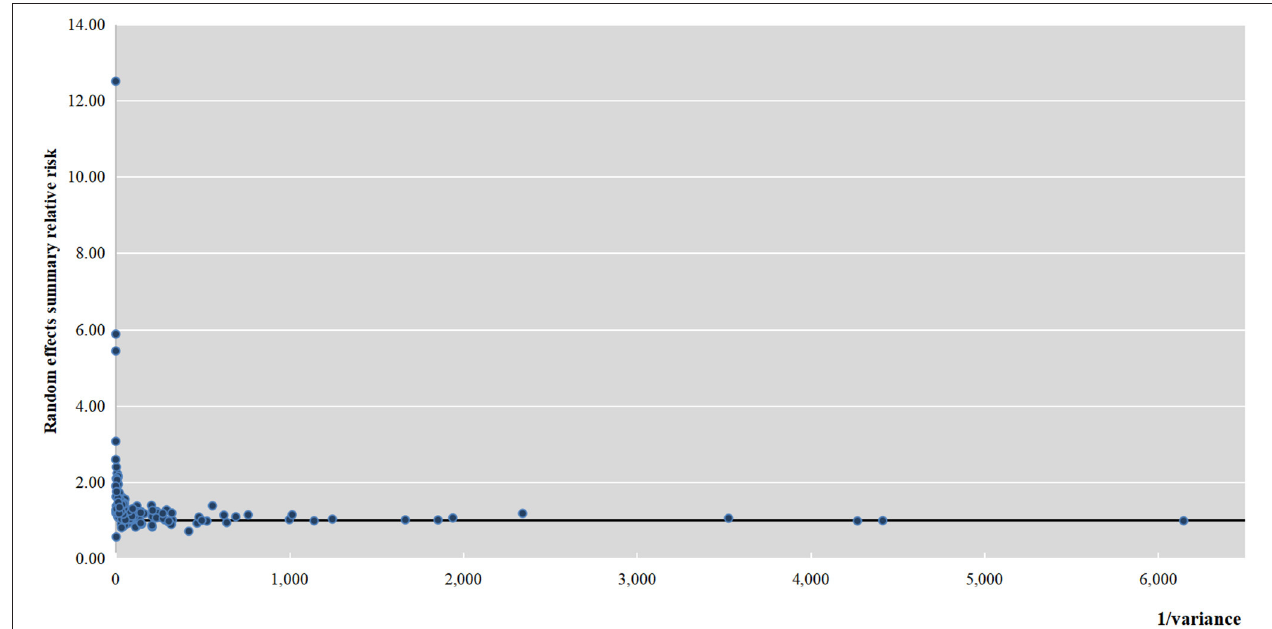
FIGURE 2 | Association of meta-analysis summary effect sizes with inverse of the variance.